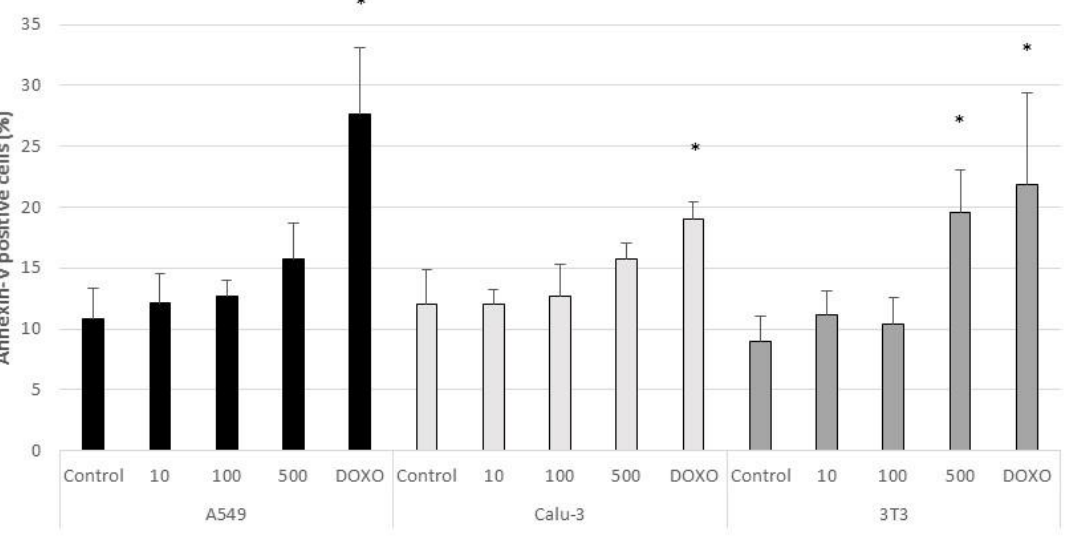
Figure 6. Apoptosis in control A549, Calu-3, and 3T3 cells and in cells exposed for 24 h to CeO 2 -NPs (10, 100, and 500 µg/mL), and to the positive control Doxorubicin. Results are expressed as means ± SD of six replicates per tested condition and three independent assays ( n = 18). Asterisks indicate significant differences with respect to the untreated control cells ( p < 0.05).